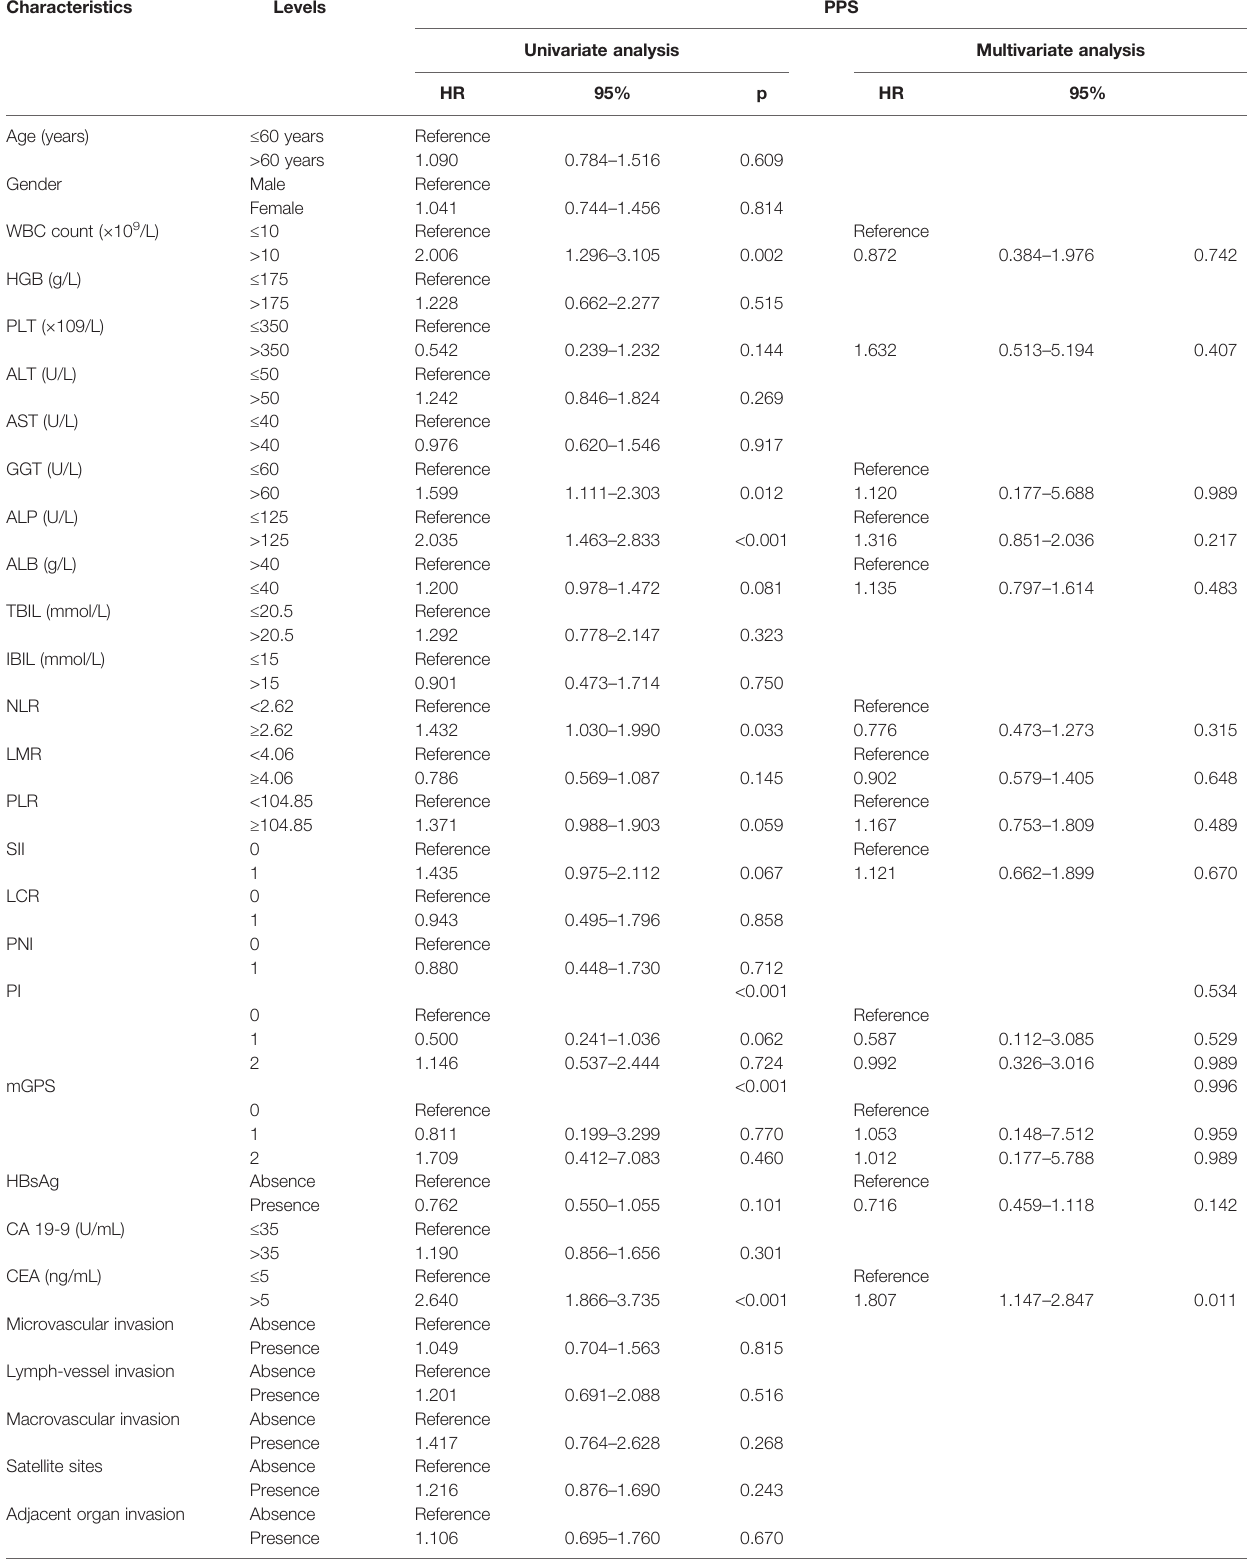
TABLE 2 | Univariate and multivariate analysis of prognostic factors of PPS.